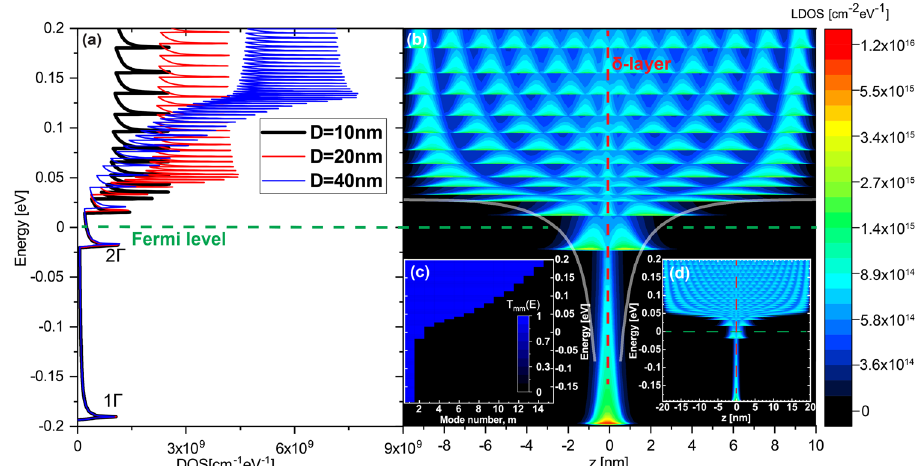
Fig. 2 Conduction band structure of δ -layer systems. a Total density of states, DOS(E), per unit length along the y -axis for Si:P δ -layer systems for distinct δ -layer depths, D . b Local density of states, LDOS(E,z), for a Si:P δ -layer system of D = 10 nm in the function of the energy and z position; the gray line indicates the corresponding charge self-consistent potential. c Transmission coef fi cient for each mode m for Si:P δ -layer system of D = 10 nm. d LDOS(E,z) for a Si:P δ -layer system of D = 20 nm. The δ -layer doping density is N D = 1.0 × 10 14 cm − 2 , the Si cap, and Si bod doping densities are N A = 1.0 × 10 17 cm − 3 , and the δ -layer thickness is t = 0.2 nm. Parts of panels ( a ) and ( b ) are reproduced with permission from Mendez et al. 49 ,